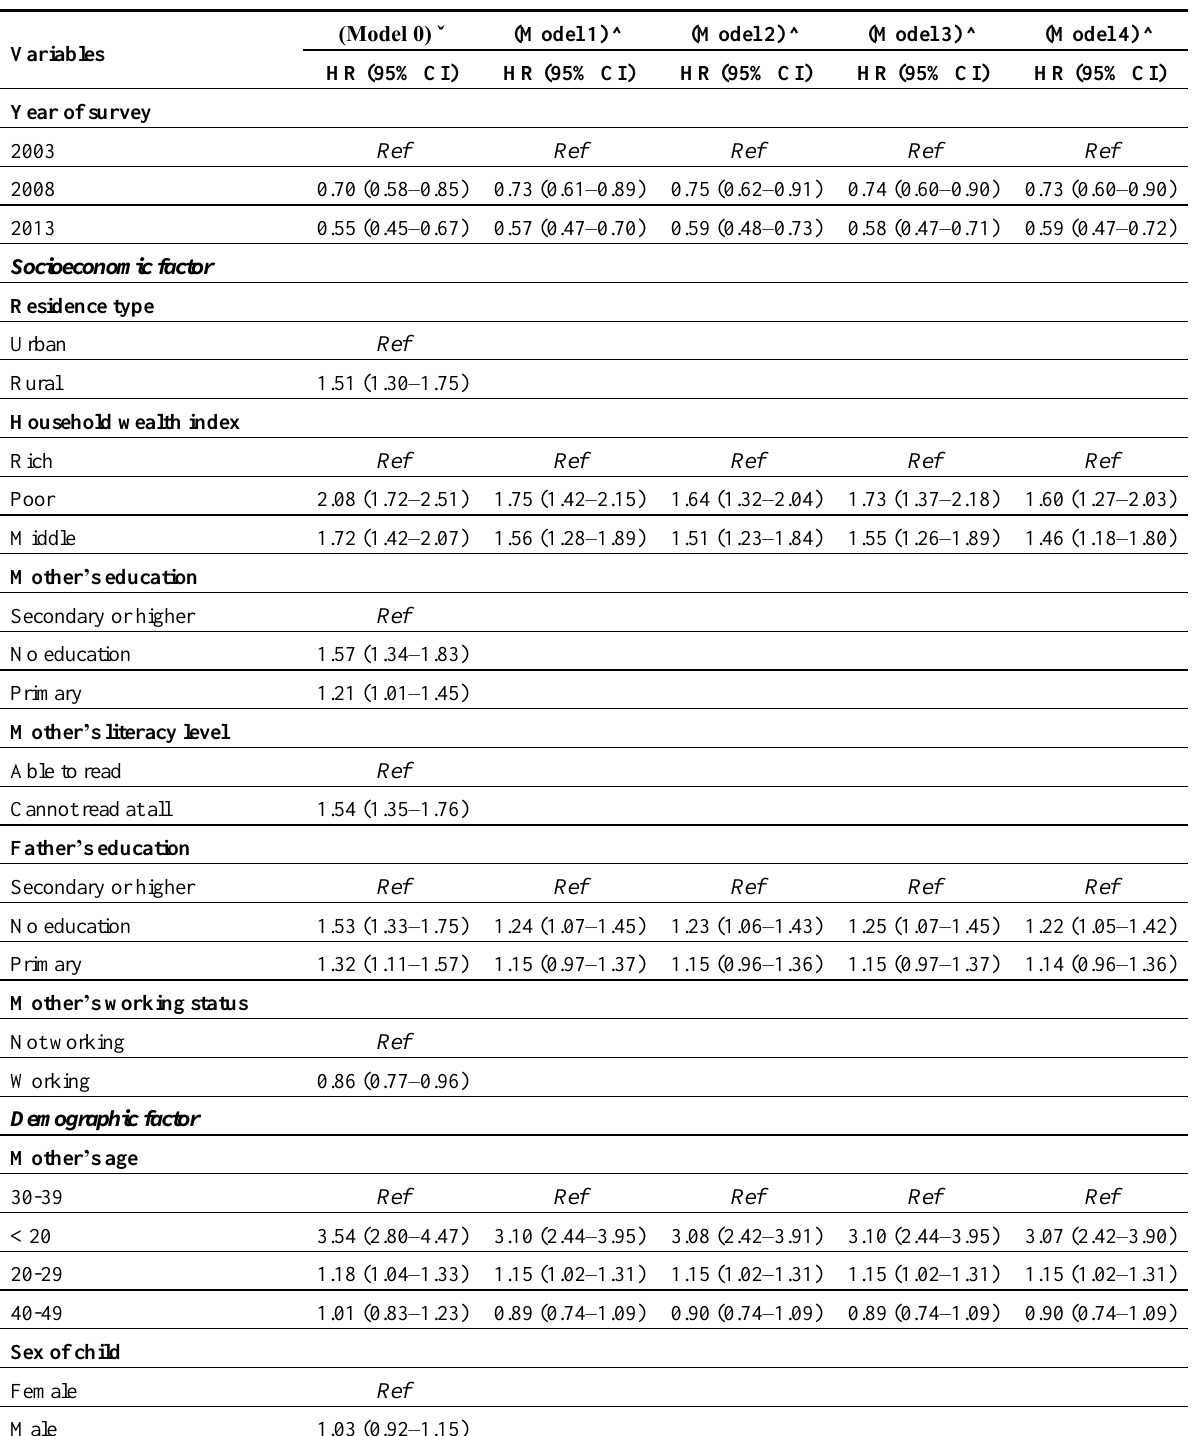
Table 4. Model for post-neonatal mortality